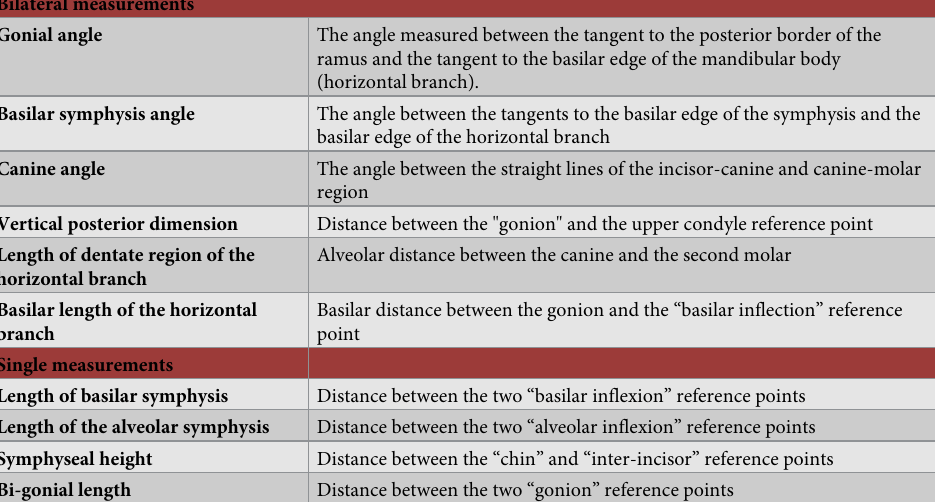
Table 1. Metric analysis protocol defining the measurements used for conventional morphometric analysis. Bilateral measurements Gonial angle The angle measured between the tangent to the posterior border of the ramus and the tangent to the basilar edge of the mandibular body (horizontal branch). Basilar symphysis angle The angle between the tangents to the basilar edge of the symphysis and the basilar edge of the horizontal branch Canine angle The angle between the straight lines of the incisor-canine and canine-molar region Vertical posterior dimension Distance between the "gonion" and the upper condyle reference point Length of dentate region of the Alveolar distance between the canine and the second molar horizontal branch Basilar length of the horizontal Basilar distance between the gonion and the “basilar inflection” reference branch point Single measurements Length of basilar symphysis Distance between the two “basilar inflexion” reference points Length of the alveolar symphysis Distance between the two “alveolar inflexion” reference points Symphyseal height Distance between the “chin” and “inter-incisor” reference points